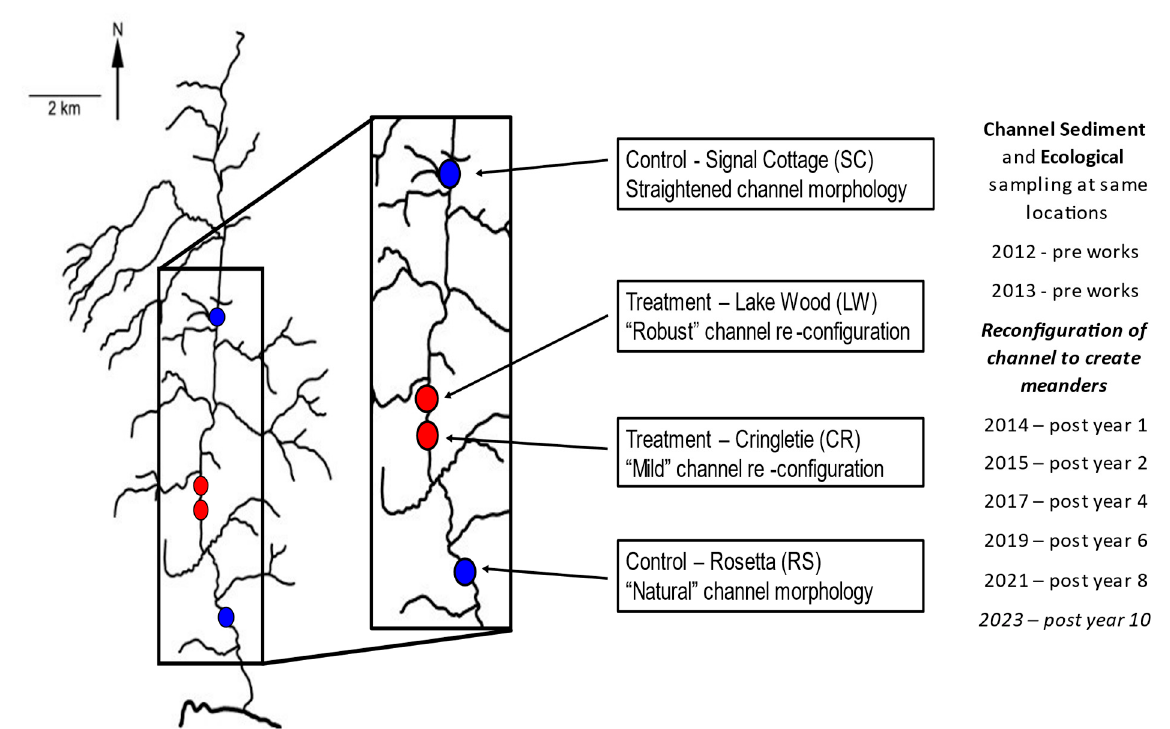
Figure 6. BACI design for Eddleston Water ecology and channel morphology monitoring and trajectory of recovery.